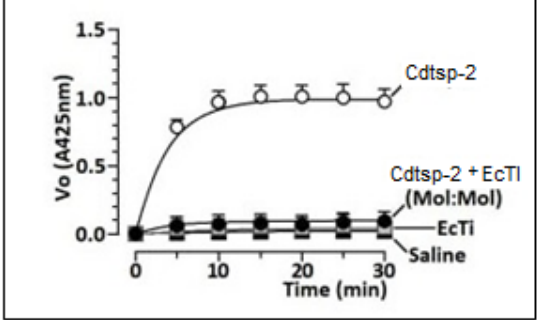
Figure 2. Graph of the enzymatic assay of Cdtsp-2 incubated with pure compounds and with EcTI protein (velocity × time). Prasa et al.’s [18] protocol was used, where the wavelength for detection was 405 nm and the protein substrate BapNa. The treatments were controlled, with substrate only, Cdtsp-2 incubated with substrate, Cdtsp-2 with protein, which were pipetted in microplate and incubated at 37 ◦ C. The readings were performed on SPECTRA MAX (Molecular Devices, San Jose, CA, USA). It is observed that a decrease in the enzymatic activity of the protein was evident in the presence of EcTI.